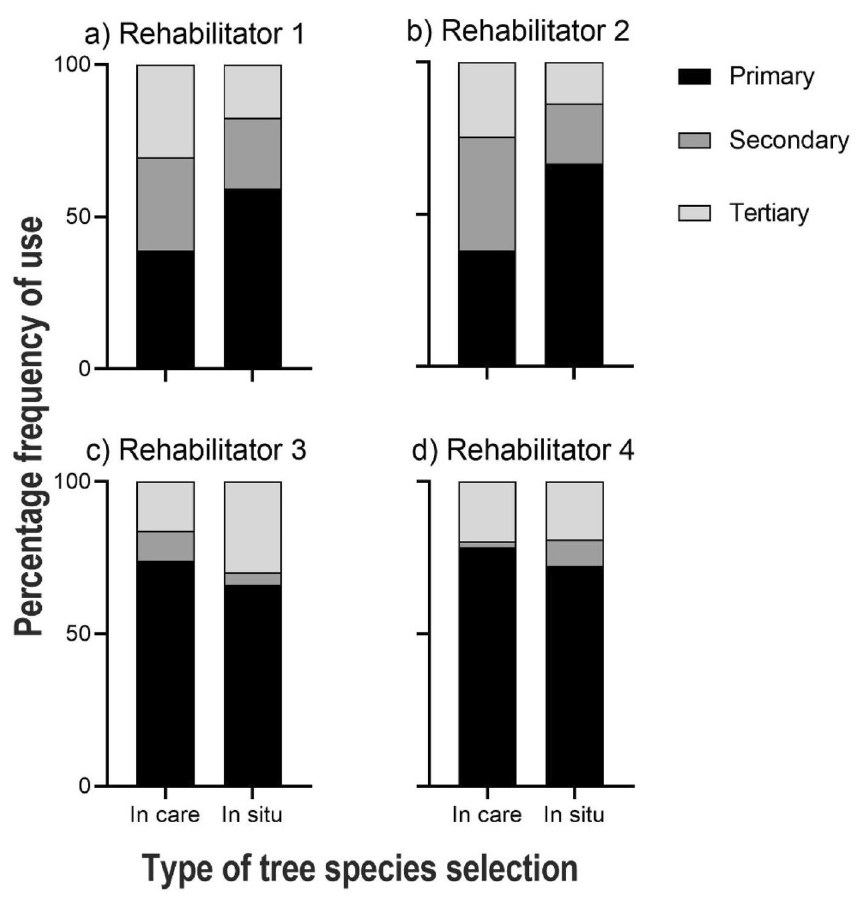
Figure 6. Comparison of the proportional distribution of tree species selected by rehabilitators for browse collection (n = 29 species) against the tree species selected by koalas in situ (n = 30 species). Tree species were grouped together based on importance to koalas, from primary to tertiary food trees, and all koalas for each rehabilitator were